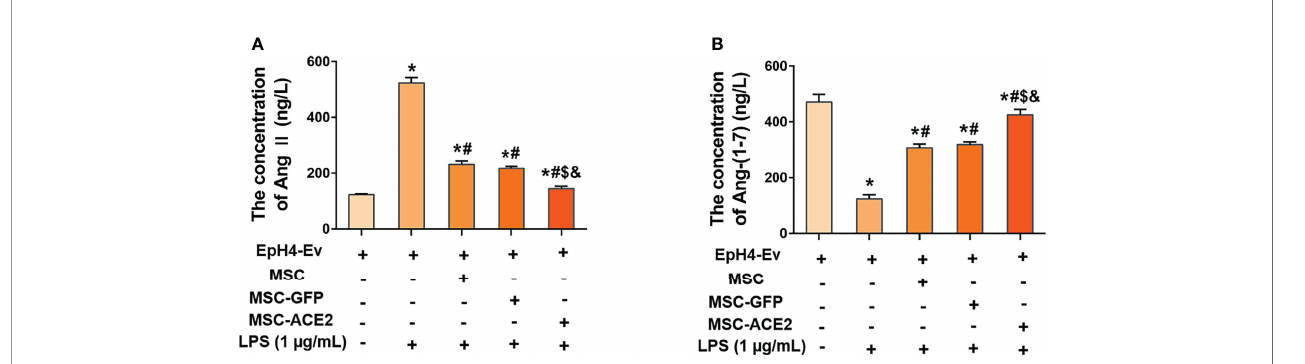
FIGURE 3 | MSC-ACE2 inhibited the LPS-induced increase in Ang II concentration and decrease in Ang-(1-7) concentration in EpH4-Ev cells. (A) Detection of Ang II concentration in cell culture supernatants by ELISA. (B) Detection of Ang-(1-7) concentration in cell culture supernatants by ELISA. Experiments were repeated three times and data were presented as the mean ± SEM (n = 4). * P < 0.05 vs. EpH4-Ev; # P < 0.05 vs. LPS; $ P < 0.05 vs. MSC; & P < 0.05